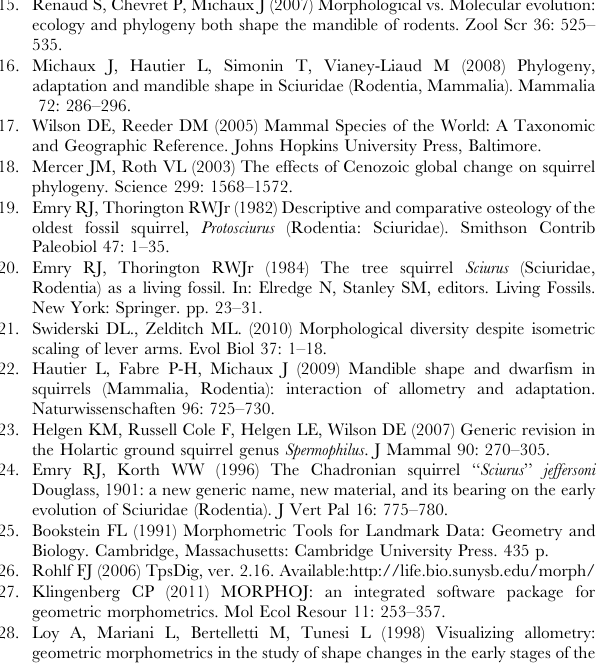
Table S4 Summary of classification results of Canoni- cal Variates Analysis (CVA) of squirrel mandible shape using the dietary categories of Michaux et al . [ 16 ] as grouping variable. Table S5 Summary of classification results of Canoni- cal Variates Analysis (CVA) of squirrel mandible shape using the locomotion categories of Michaux et al . [16] as grouping variable. The fossil Douglassciurus jeffersoni was assigned to the arboreal/scansorial group with p